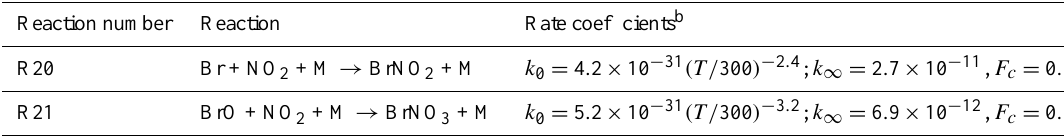
Table 2b. Tropospheric bromine chemistry in GEOS-Chem: three-body reactions a . Reaction number